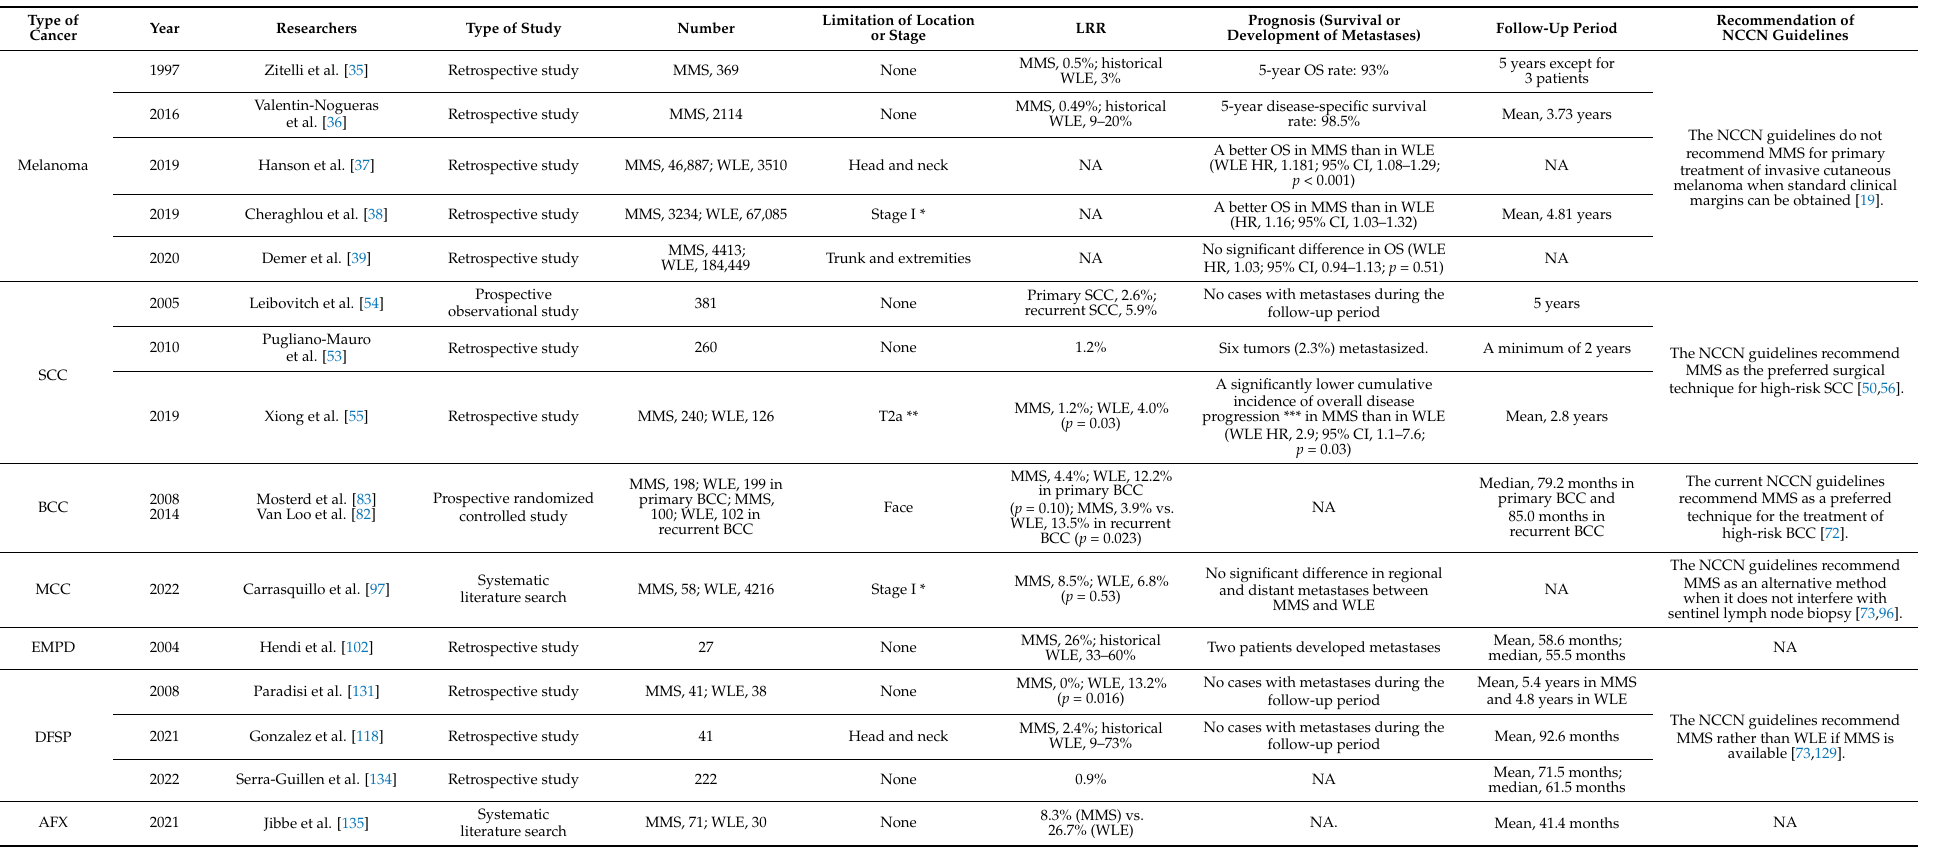
Table 3. Previous representative studies to evaluate the effect of MMS and recommendations of the current NCCN guidelines for MMS for each skin